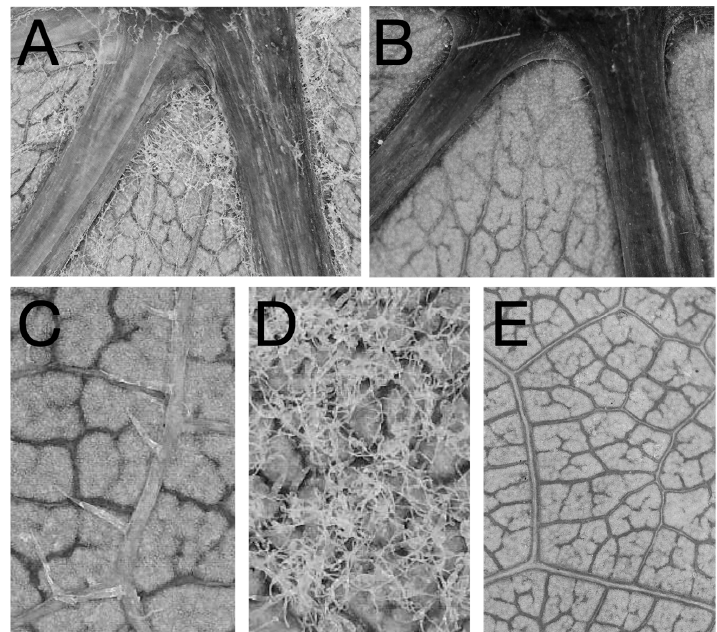
Figure 1. Photographs of phenotypes evaluated in the common garden study: ( A ) a relatively large, dense mite domatium. ( B ) A vein axil of a cultivar that lacked mite domatia. Cultivars ranged from having ( C ) leaf bristles and ( D ) leaf hairs present to those with glabrous abaxial leaf surfaces ( E ). Samples used for photographs were from accessions (from top left to bottom right)